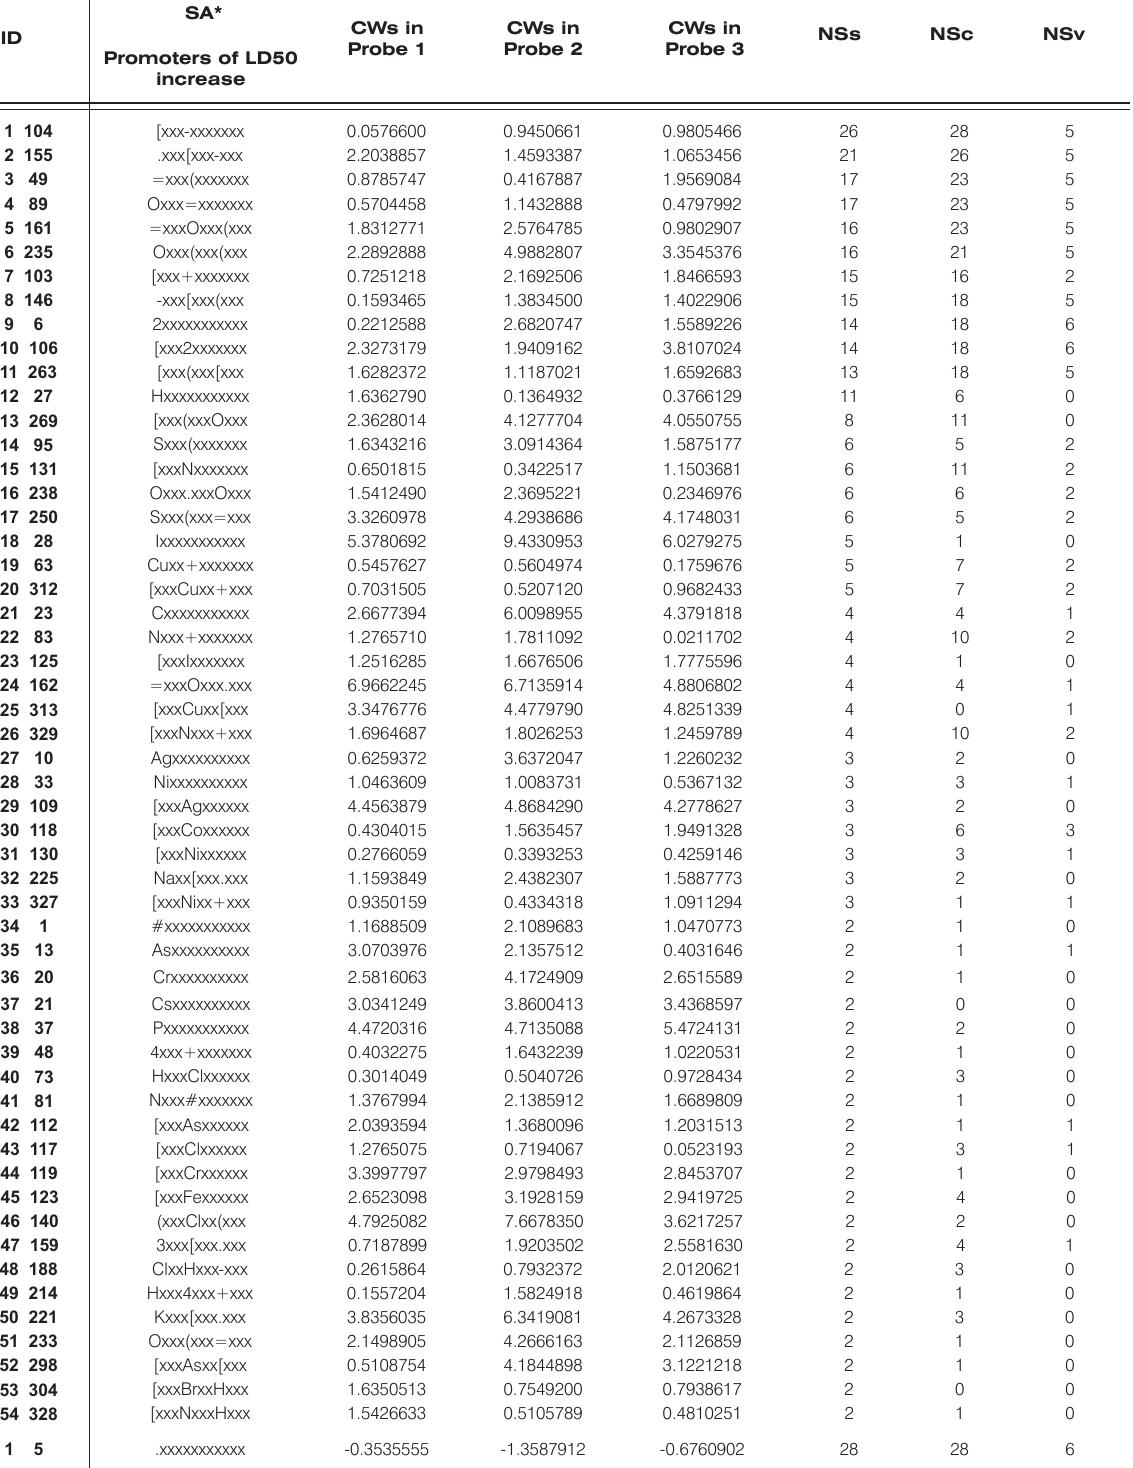
Table 2. Correlation weights of SMILES attributes (SA) which have been obtained for split A using the threshold 2. ID contains two integers: the first is numbering for the given category; the second is the number of SA in the general list of SA for all 85 substances. The NSs, NSc, and NSv are the numbers of SMILES which contain the SA in the subtraining, calibration, and validation sets, respectively. The ‘x’ denotes a vacant place in the string (twelve symbols) assigned for registration of SMILES